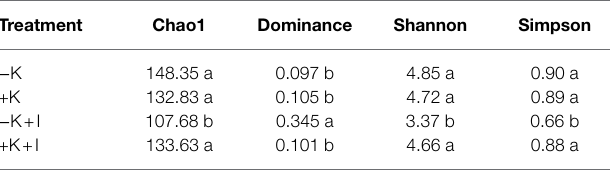
TABLE 2 | Alpha diversity of fungi community in flag leaf sheath after Sarocladium oryzae inoculation. Treatment Chao1